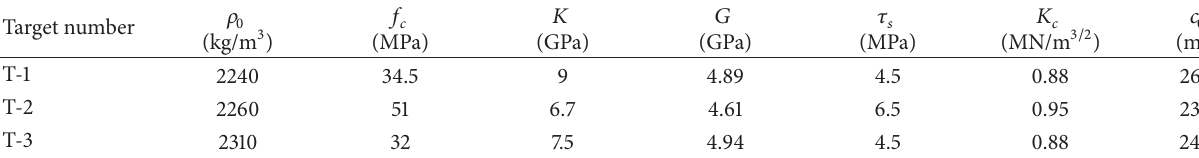
Table 2: The concrete target parameters [15, 16, 28–30].